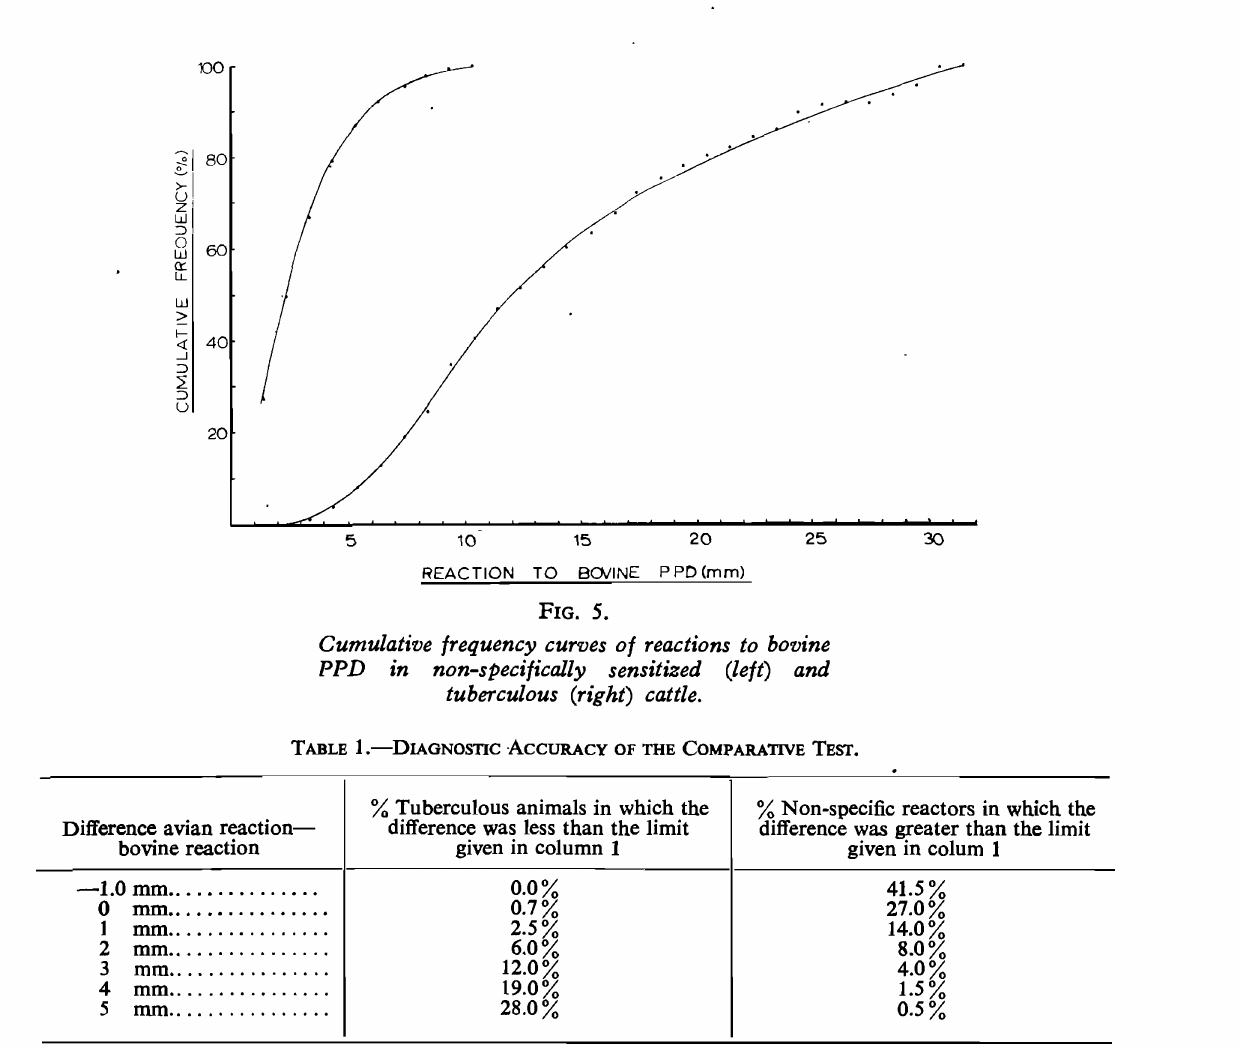
Difference avian reaction bovine reaction